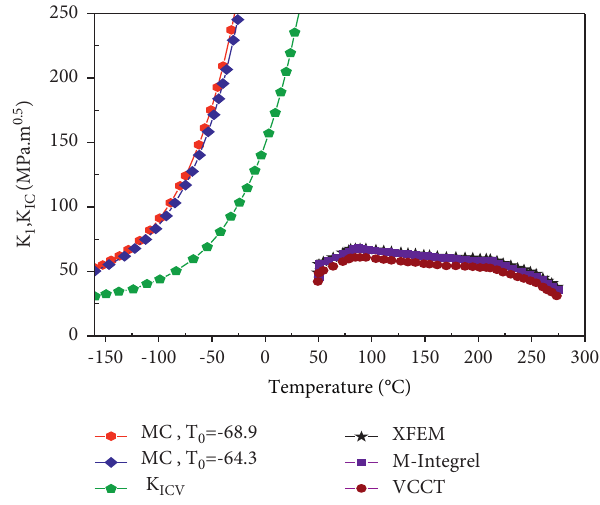
Figure 21: Comparison of K